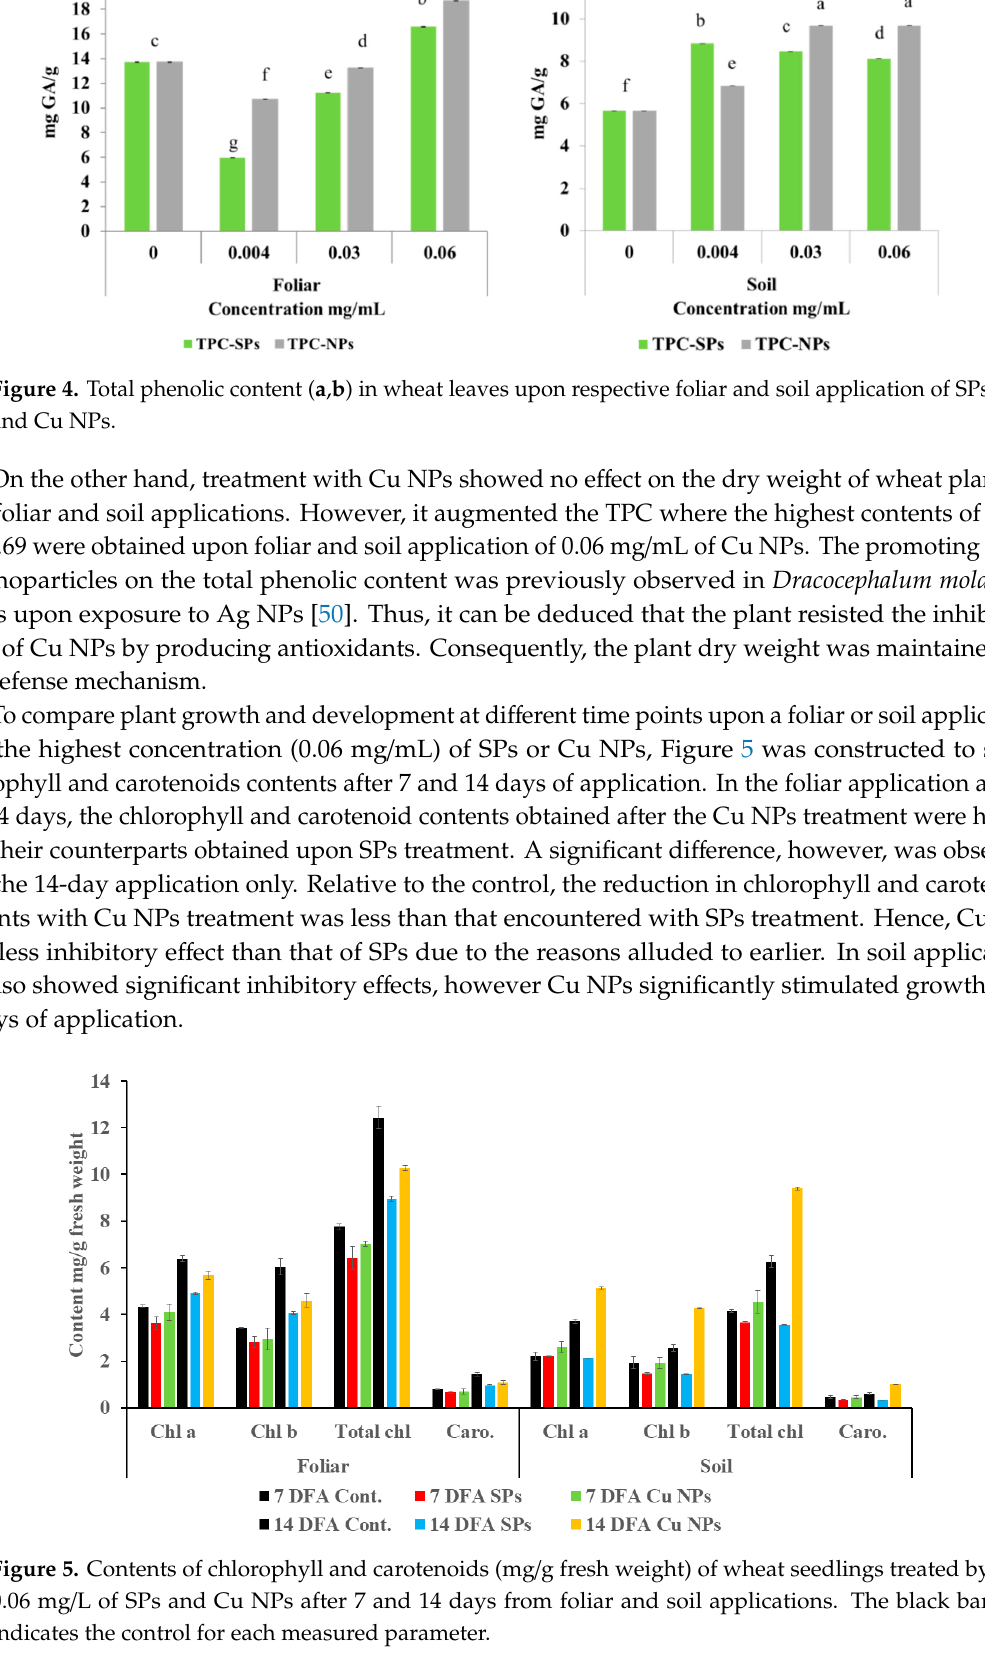
Figure 6. Dry weight and total phenolic content of wheat seedlings treated by 0.06 mg/L of SPs and Cu NPs after 28 days from foliar and soil applications.